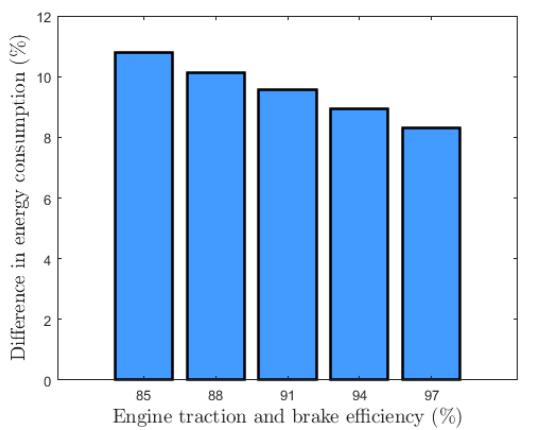
Figure 12. Difference in energy consumption at the pantograph (in %) between the considered driving strategies for different values of the engine traction and brake efficiency in Puertollano–Ciudad Real section.